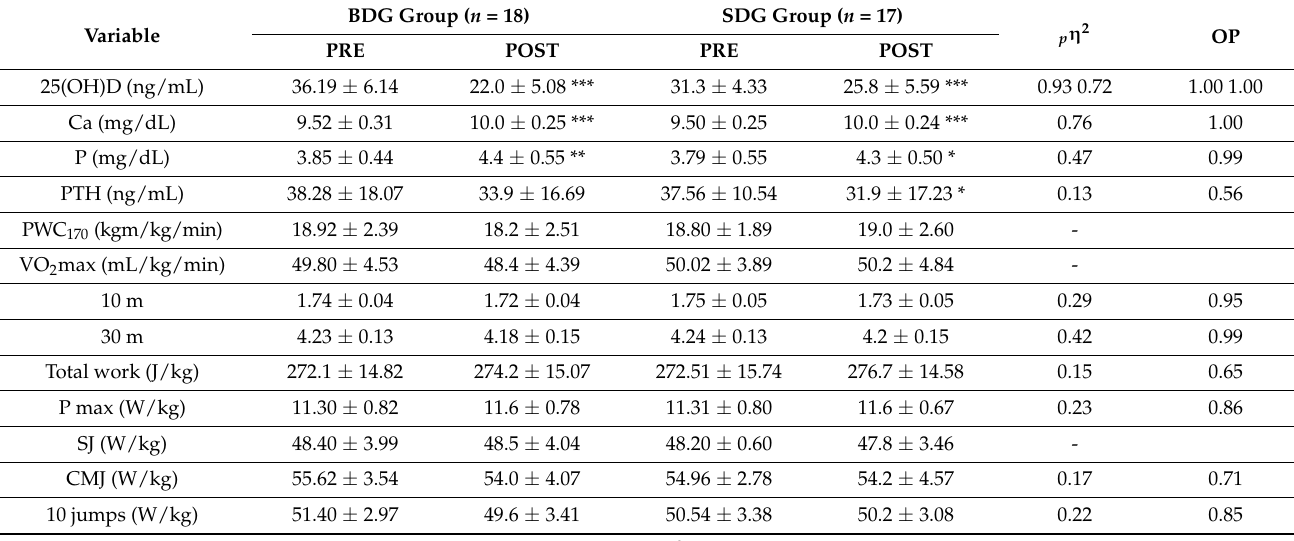
Table 4. Changes in selected biochemical indicators of blood and physical fitness in young football players in the group with large (BDG) and small (SDG) drops of 25(OH)D before (PRE) and after (POST) testing program.